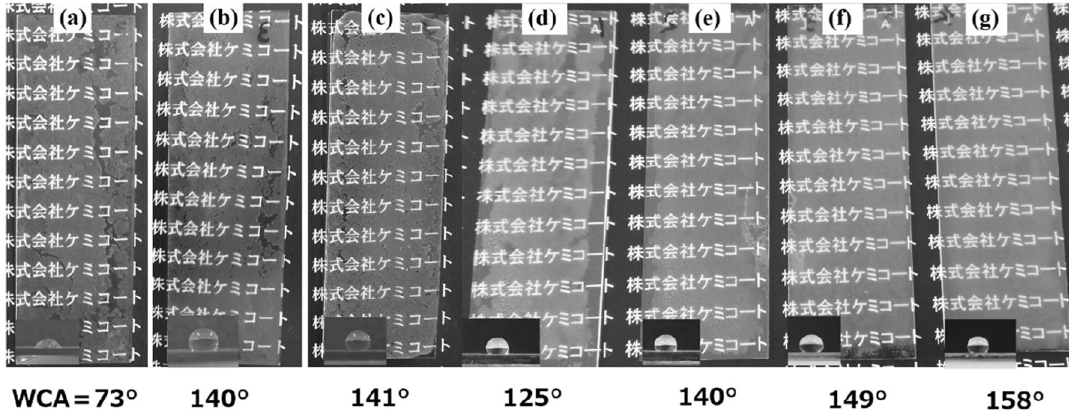
and c No. 3; Processing method II: Compositions ( d ) No. 3 and f No. 5; Processing method III: Compositions ( e ) No. 3 and g No. 5. The inserts were optical photographs of a 10 μL water droplet on the coating surface showing the water